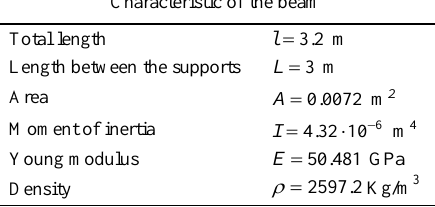
Characteristic of the